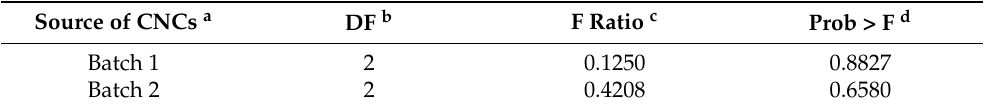
Figure 1. Turbidity curves for titrations of solutions of chitosans with different molecular weights with ( a ) CNC-18 suspensions and ( b ) CNC-33 suspensions. (The dashed lines are merely visual guides. Each data point is a mean of three measurements. The error bars correspond to ± one standard deviation.) The inset shows the averaged data for CNC-18 and CNC-33. S/N ratio = number of CNC sulfate groups divided by number of chitosan amino groups, 100 − Transmittance of deionized water = 0%. Table 3. One-way ANOVA test results ( α = 0.05) for the effect of molecular weight of the commercial chitosan samples on the turbidity.